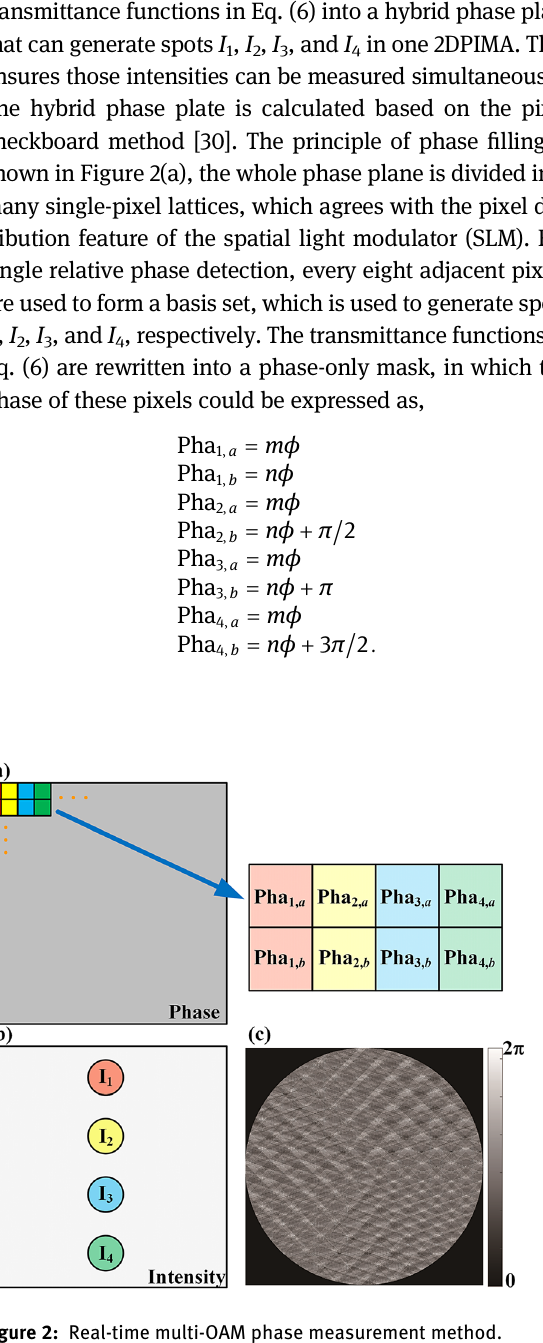
Figure 2: Real-time multi-OAM phase measurement method. (a)Schematicofthephasefillingprincipleofthehybridphaseplate. (b) Two-dimensional phase-to-intensity measurement array. (c) The hybrid phase plate is used to generate an eight-spot 2DPIMA that can measure the real-time relative phase of two OAM states l = 1 and l =